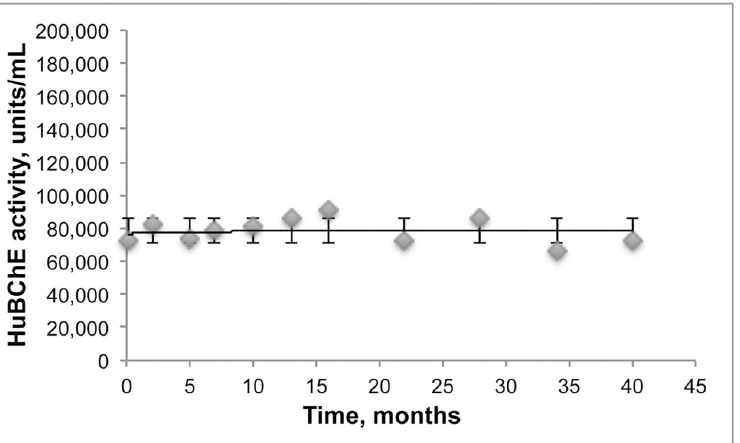
Fig 12. HuBChE lyophilized from 0.1 mL of 144 mg/mL and stored dry at 27˚C for up to 40 months was reconstituted by addition of water. The lyophilized HuBChE was stable as a dry powder over the 40 month storage